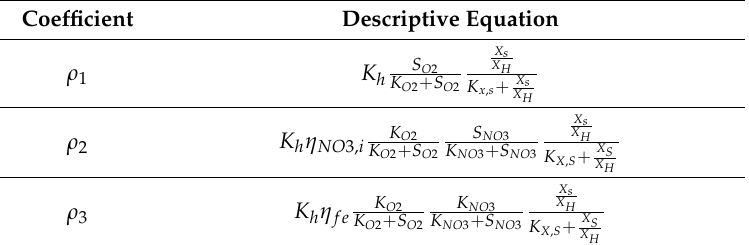
Table 2. Definition of the equations’ coefficients.